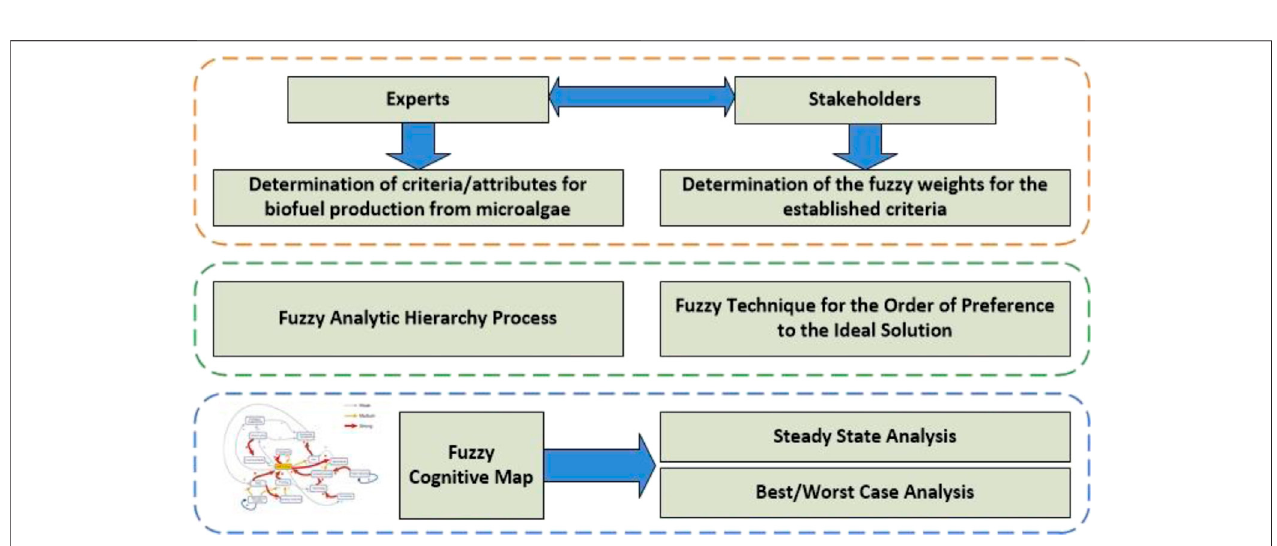
FIGURE 1 | The logical architecture of the participatory modeling approach.